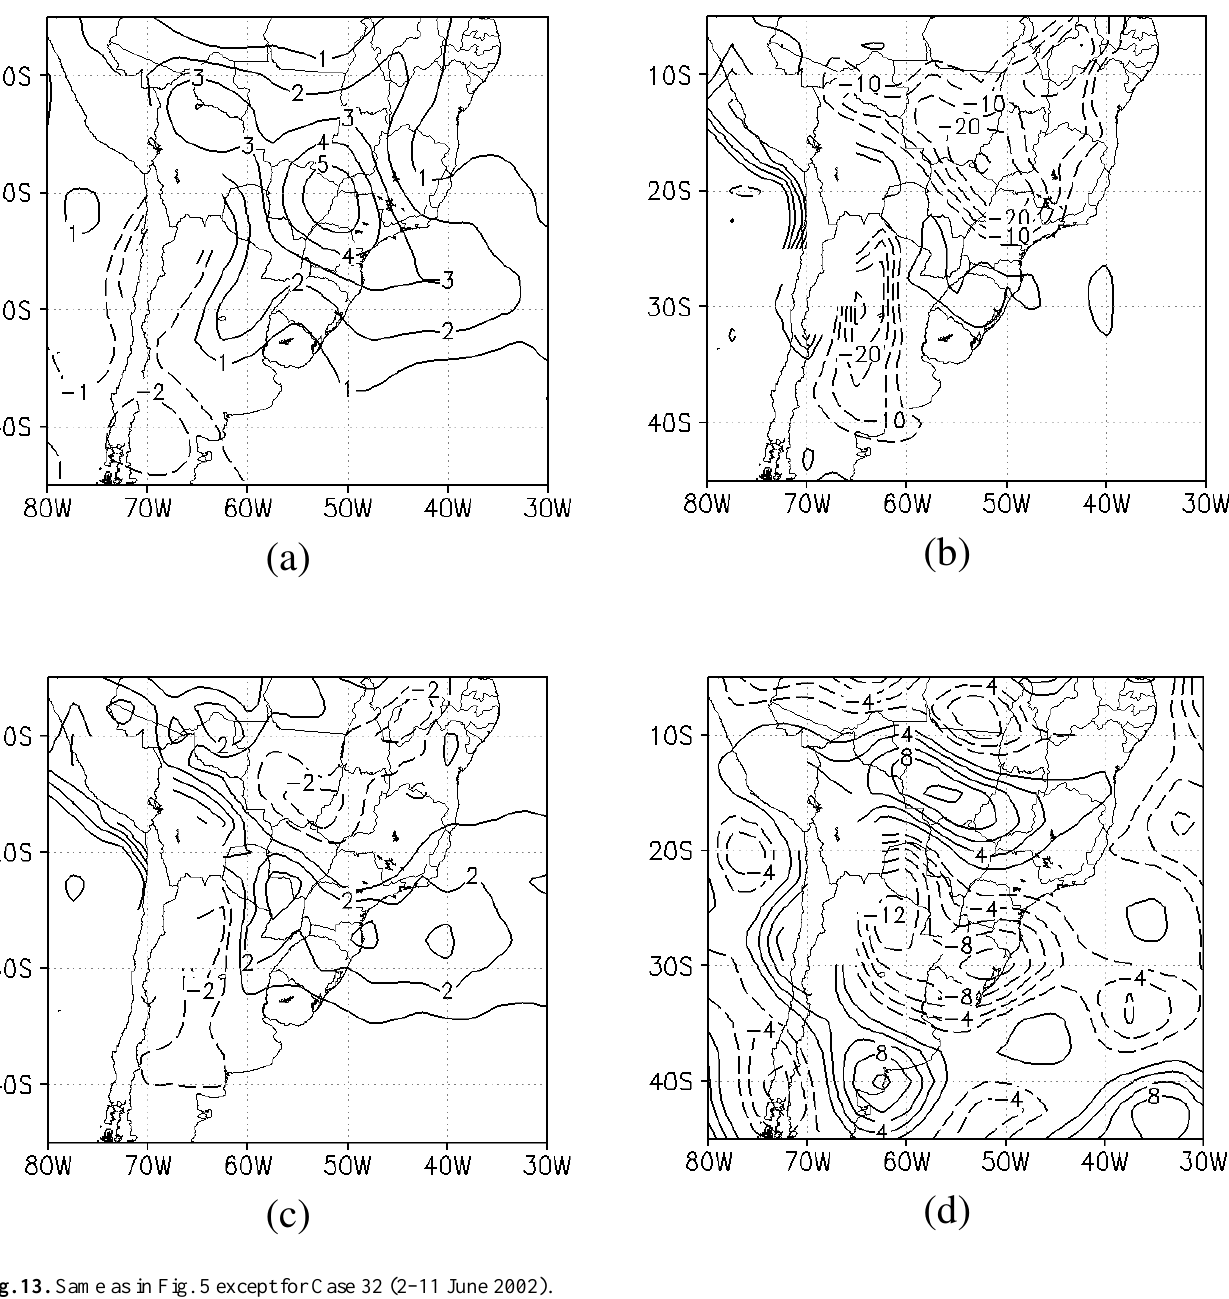
The sequence of the 500-hPa geopotential and its anomaly from 29 May through 12 June 2002 (not shown) shows a strong ridge propagating slowly from 130 ◦ W to 110 ◦ W in the Pacific in 8 days from 29 May to 5 June. From 5 to 8 June a strong trough has formed north of 47 ◦ S and, along with the ridge to the south, the geopotential field resembles an inverted omega blocking configuration. On 12 June the ridge moves to 90 ◦ W. The short wave trough off Chile at 30 ◦ S remains stationary in the eastern South Pacific till it